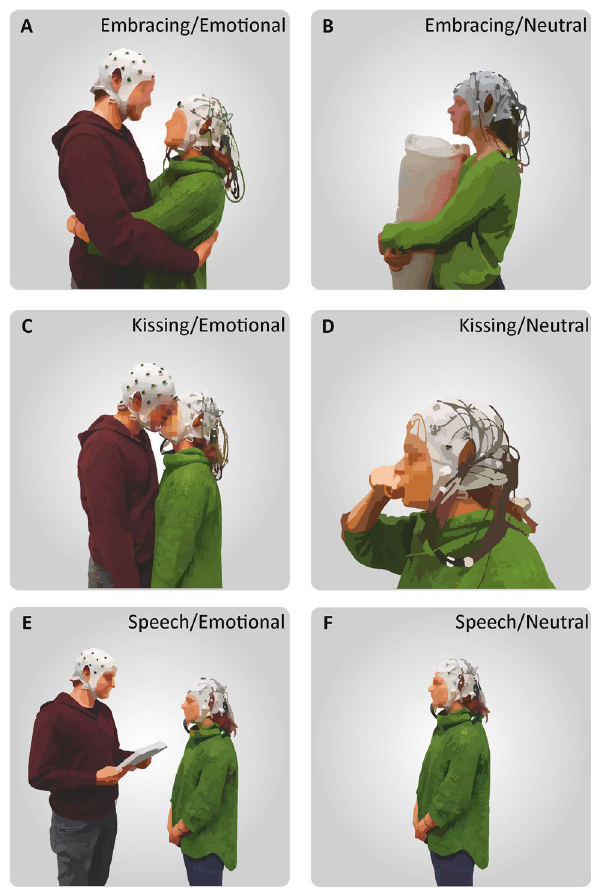
Figure 1. Depiction of the behavioral tasks. ( A ) During the emotional condition, the participant wearing the mobile EEG system embraced his/her partner in a frontal embrace. ( B ) During the neutral condition, the participant embraced a pillow with the partner absent. ( C ) In the emotional kissing condition, the partners kissed each other without using their tongue. ( D ) During the neutral condition, the recorded participant performed a kiss with his or her own hand. ( E ) In the emotional speech condition, the recorded participant listened to an emotional text written by their partner prior to the session about shared life experiences. ( F ) In the neutral speech condition, the recorded participant listened to a pre-recorded weather report without the